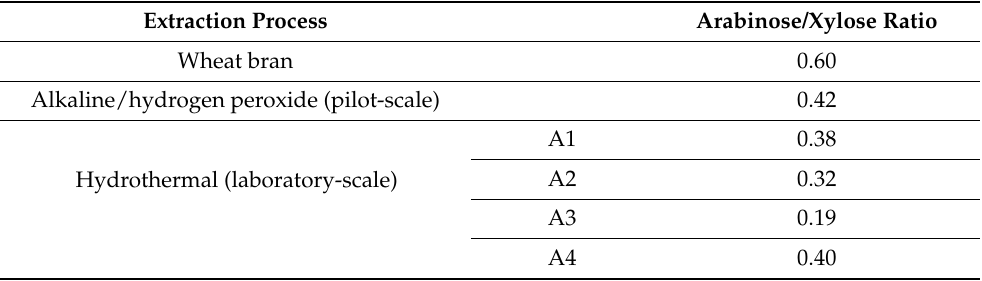
Table 3. Arabinose/xylose ratios of various arabinoxylan